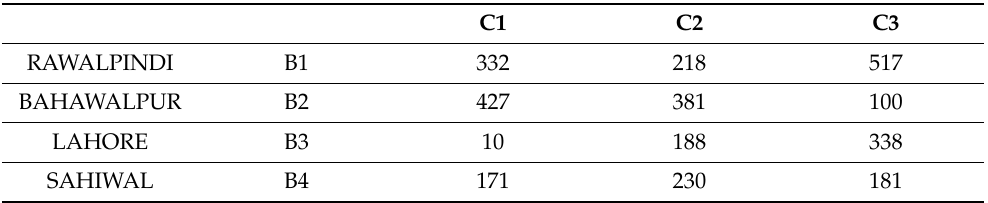
Table A6. Transportation cost of wood pellets between pelletization plants and distribution centers (USD/ton-km).